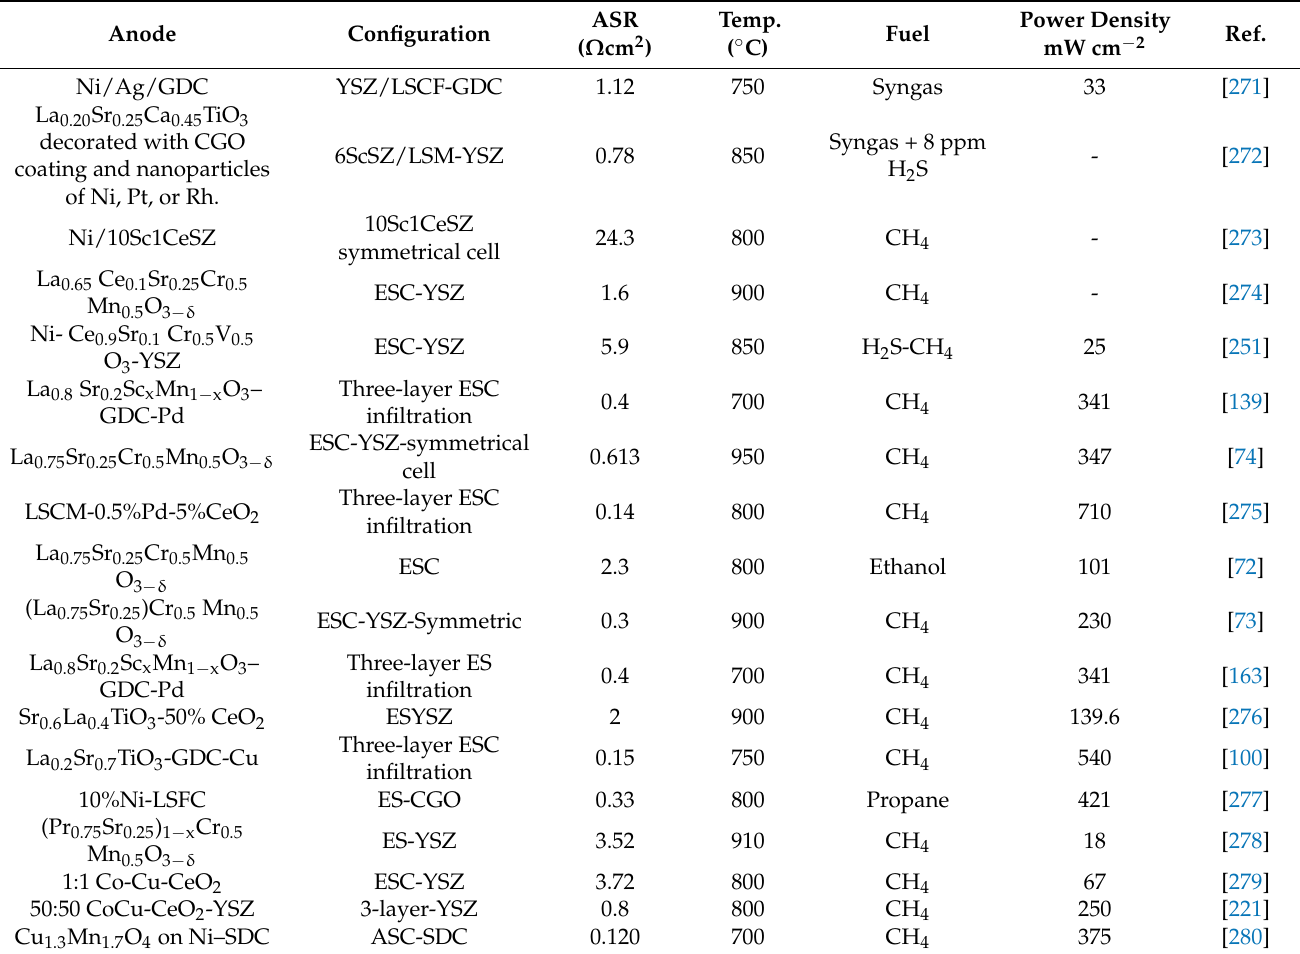
Table 3. The ASR and power densities of SOFCs fabricated from hydrocarbon compatible anodes. Anode Configuration